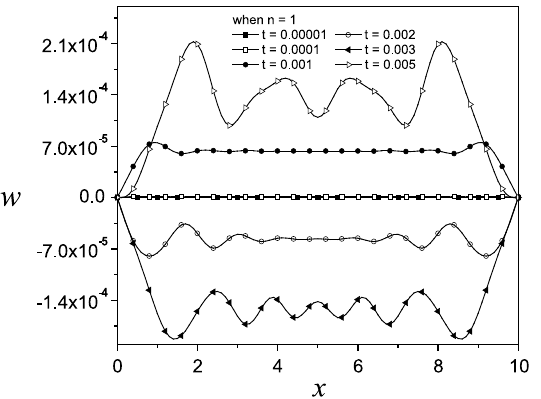
Fig. 15. Deflection of the mid-plane for the simply supported FGPM cylindrical shell imposed by a uniform mechanical load, when t = 1 × 10 − 4